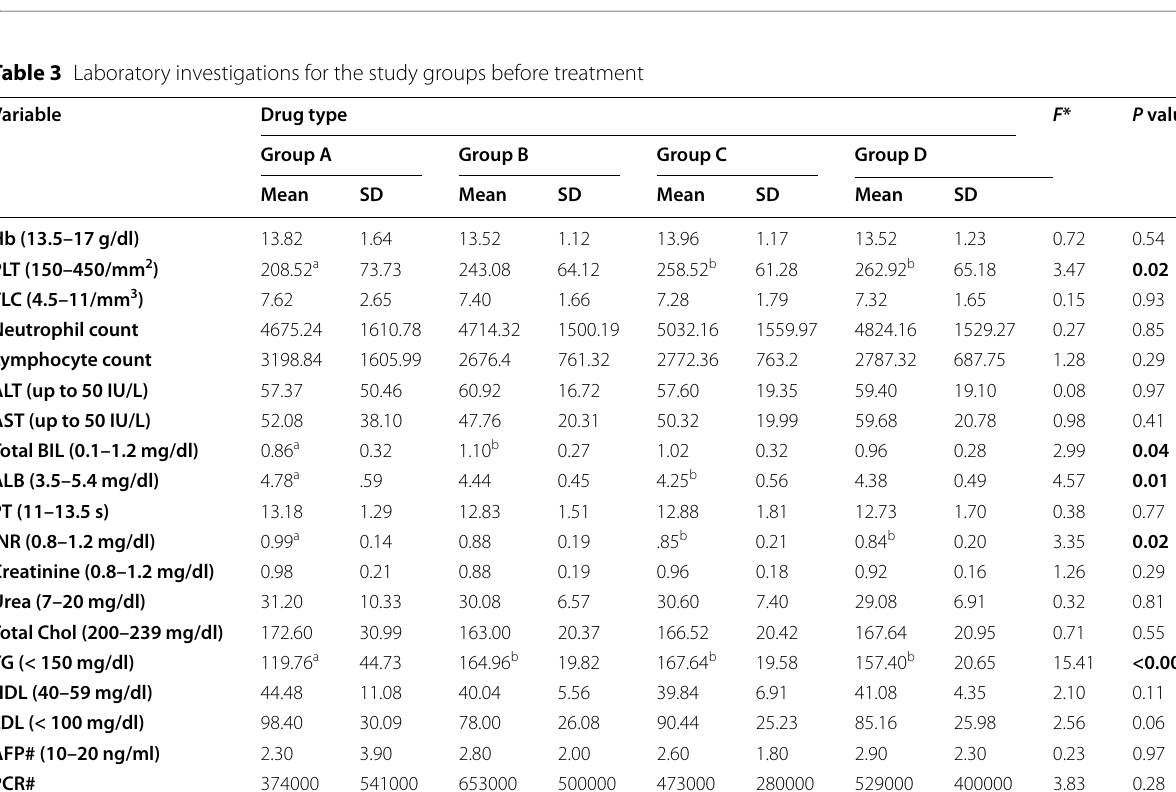
Fig. 1 Comparison of demographic data (height, weight, and BMI) between the study groups